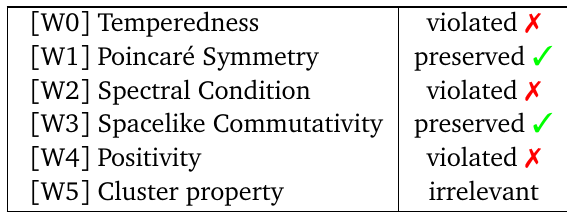
Table 1: Wightman axioms for Wightman functions in the Minkowski